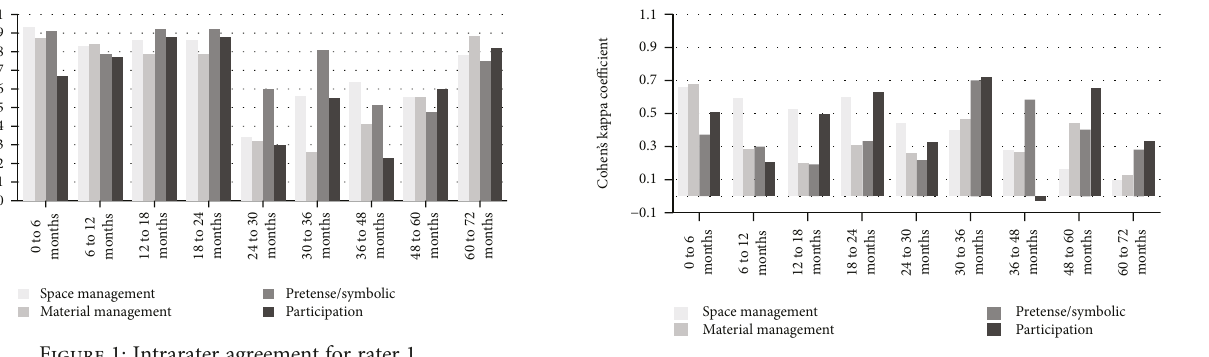
Figure 3: Interrater agreement.